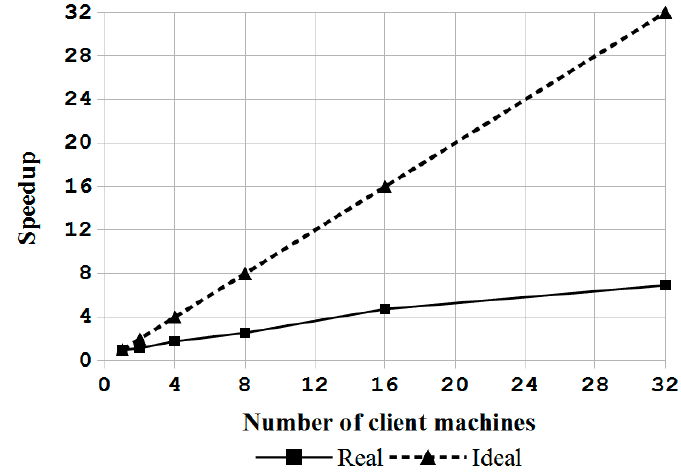
Figure 9. Speedup for deploying massive computers using multicast mechanism.